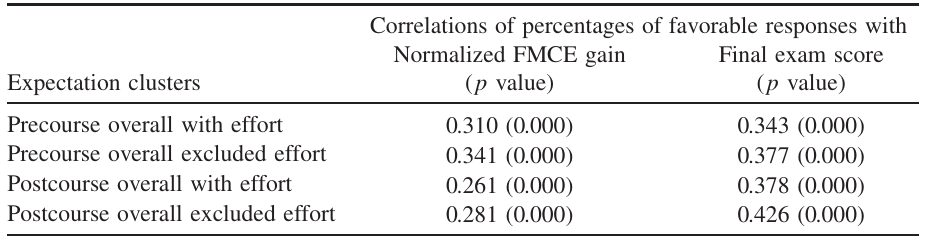
TABLE X. Comparison of Pearson-r correlation coefficients.